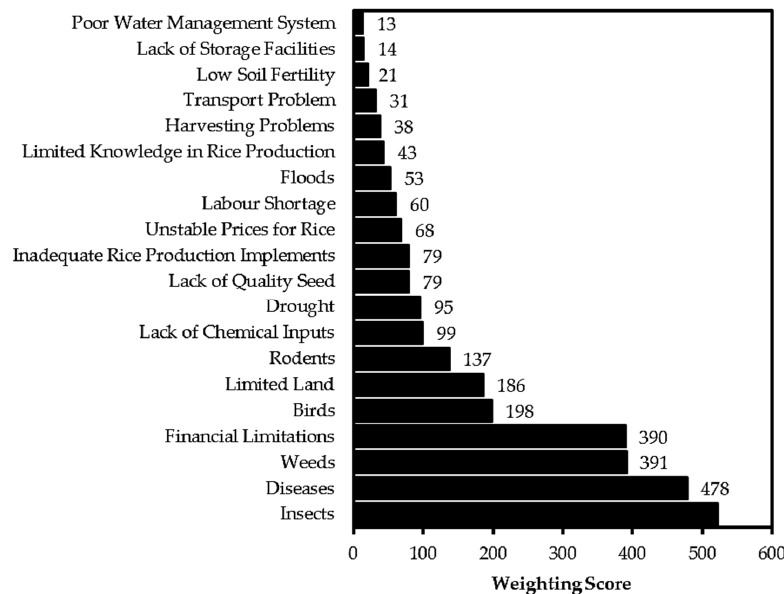
Figure 3. Rice production constraints in the survey areas.